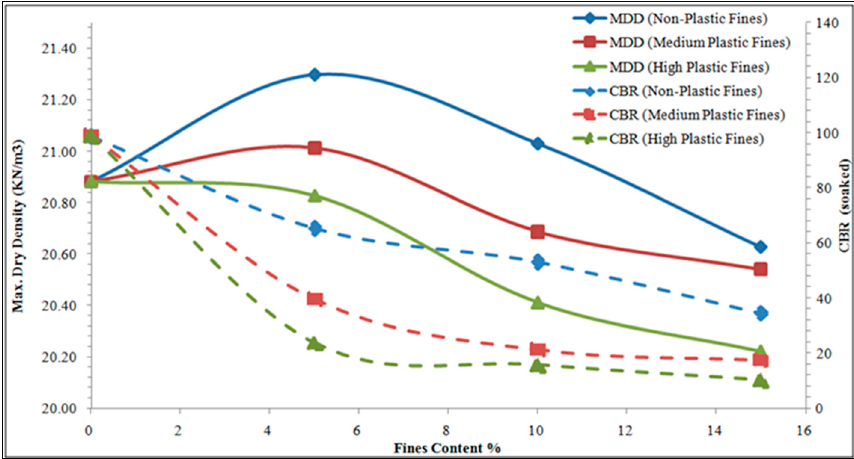
Figure 5. Effect of fines on the MDD and CBR values for the composite samples (gradation C).